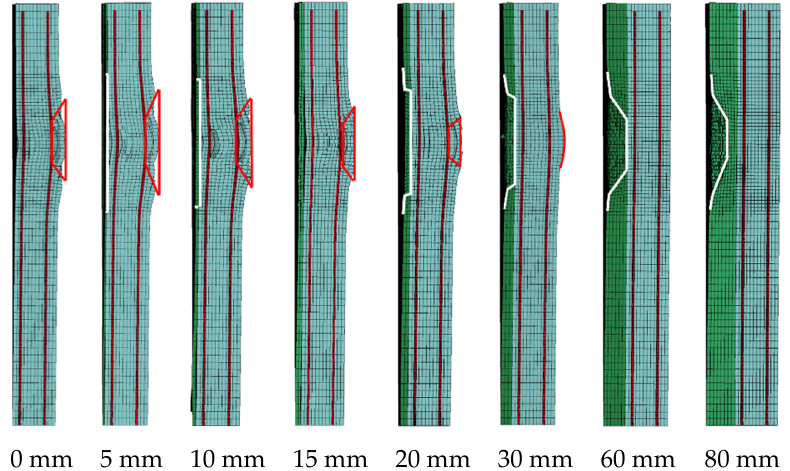
Figure 18. Typical damage results for the RC walls with different coating thicknesses.